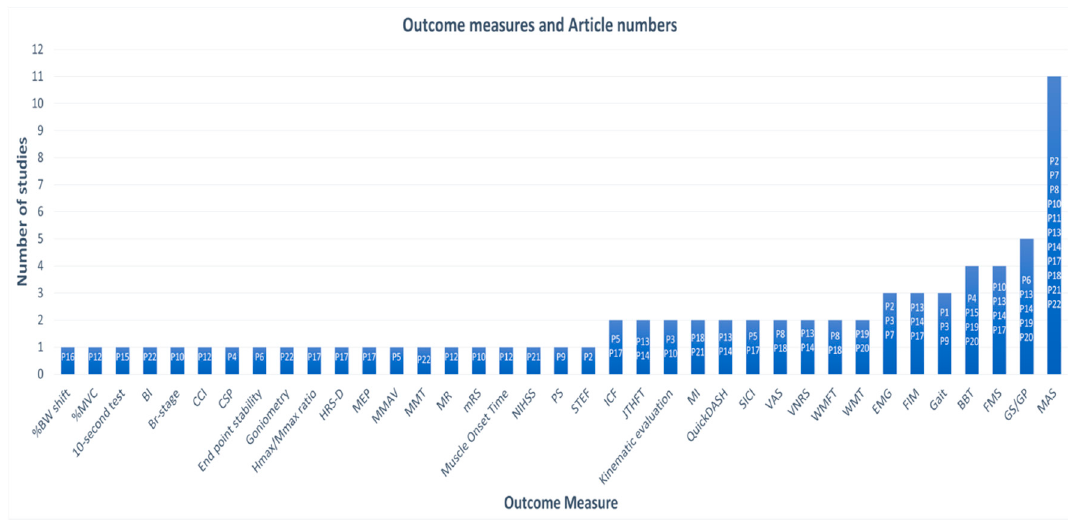
Figure 4. Outcome measures used and number of studies using each outcome measure.